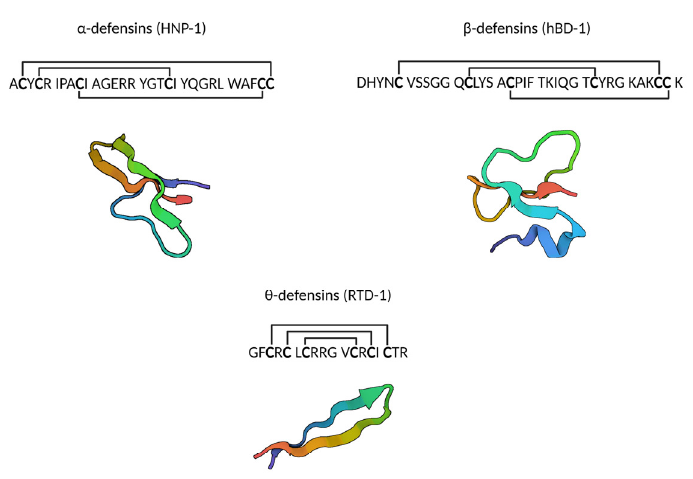
Figure 1. The three subfamilies of defensins, with an example sequence and accompanying structure. PDB codes of structures: 3GNY (HNP-1), 1E4S (hBD-1) and 2LYF (RTD-1) [23–25]. Created with BioRender.com.